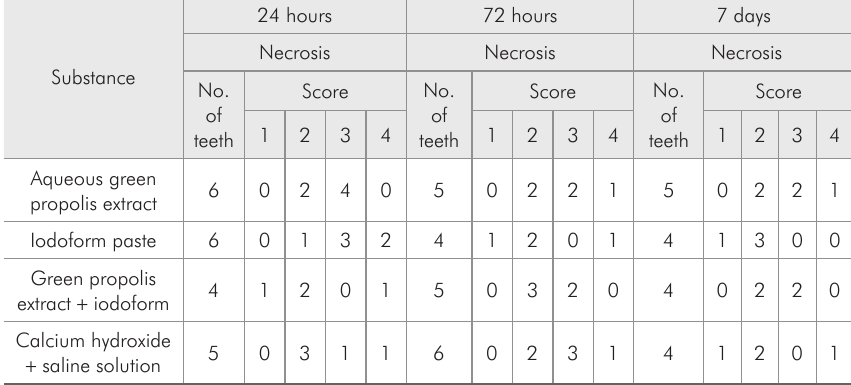
of teeth according to substances tested, evaluation time and presence of necrosis.*